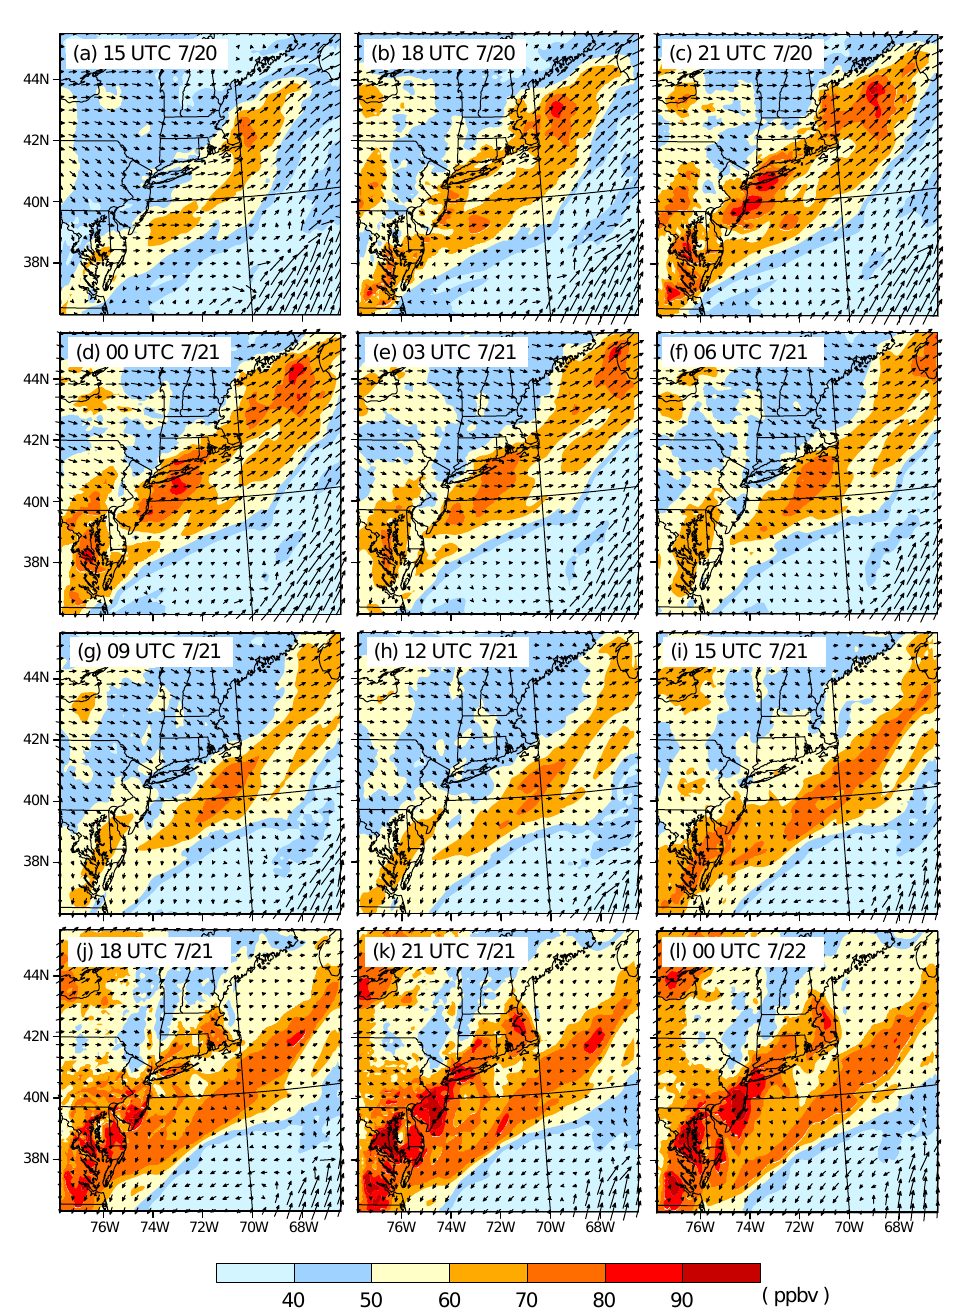
Fig. 9. Horizontal distributions of simulated O 3 mixing ratios and horizontal wind fields from 15:00 UTC on 20 July to 00:00 UTC on 22 July with 3-h intervals. The ozone mixing ratios and horizontal wind fields are vertically averaged from near surface to about